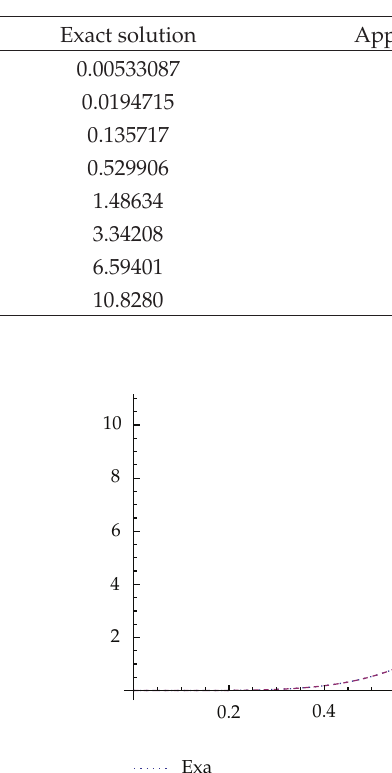
Table 3: Numerical results for n (cid:9) 128 for Example 4.3.